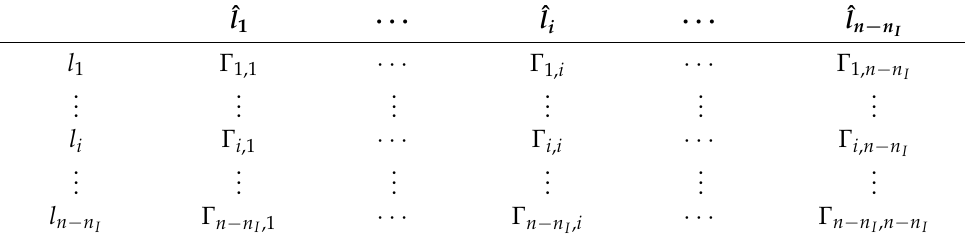
Table 1. Confusion matrix Γ